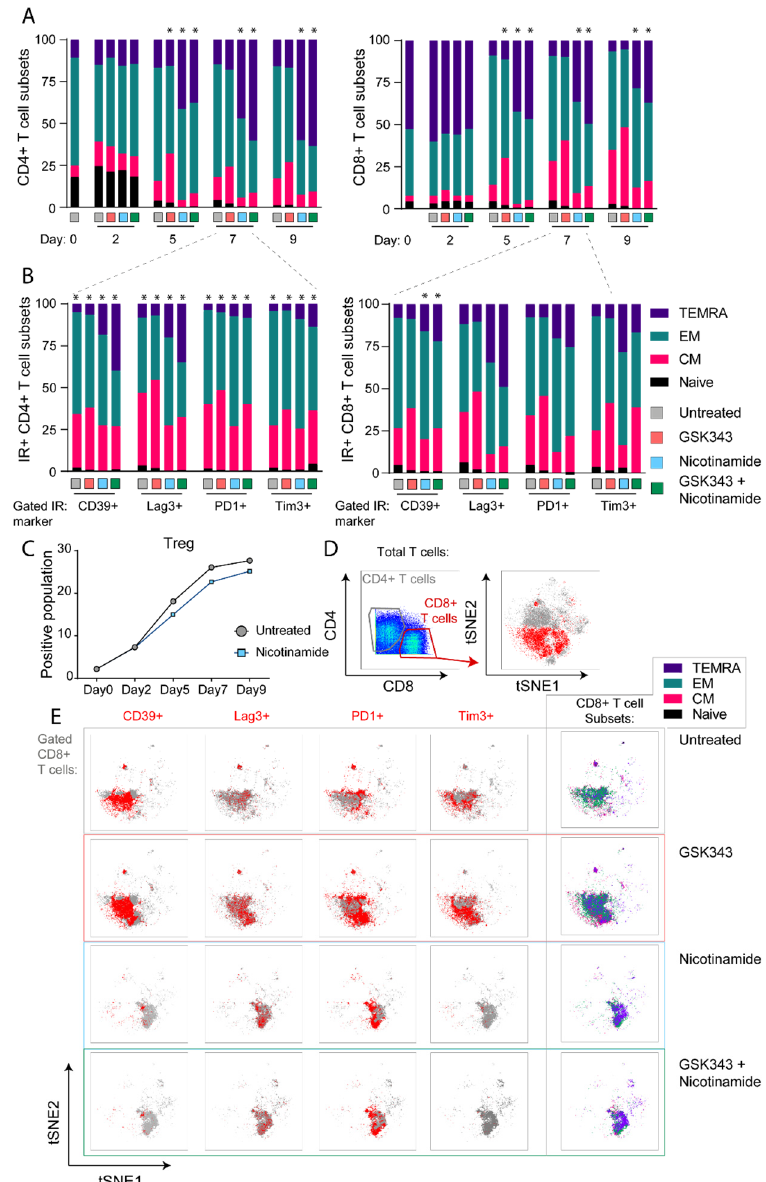
Figure 4. The effects of EZH2i and NAM in T cell differentiation states. ( A ) GSK343 treatment largely matches untreated subsets as tracked through in vitro stimulation time course, with significant increase in central memory subset on day five. NAM drives a high TEMRA proportion in both CD4+ and CD8+ T cells. ( B ) T cells were gated to IR+ cells and assessed for proportions of differentiation subset proportions, on day seven. Assessed by chi-squared analysis (* p < 0.05). TEMRA, T effector terminally differentiated; EM, effector memory; CM, central memory. ( C ) Treg phenotype tracked through treatment groups by mass cytometry (CD25+ CCR4+ of CD4+ T cells). ( D ) Representative plot showing T cells on day seven gated for CD4+ and CD8+ and as a tSNE representation, with CD8+ T cells highlighted in red, and of the CD8+ T cells, ( E ) positioning of IR+ cells (in red) and subsets (indicated by color key: TEMRA purple, EM aqua, CM pink and naïve black) across ex vivo comparison and the range of in vitro treatment